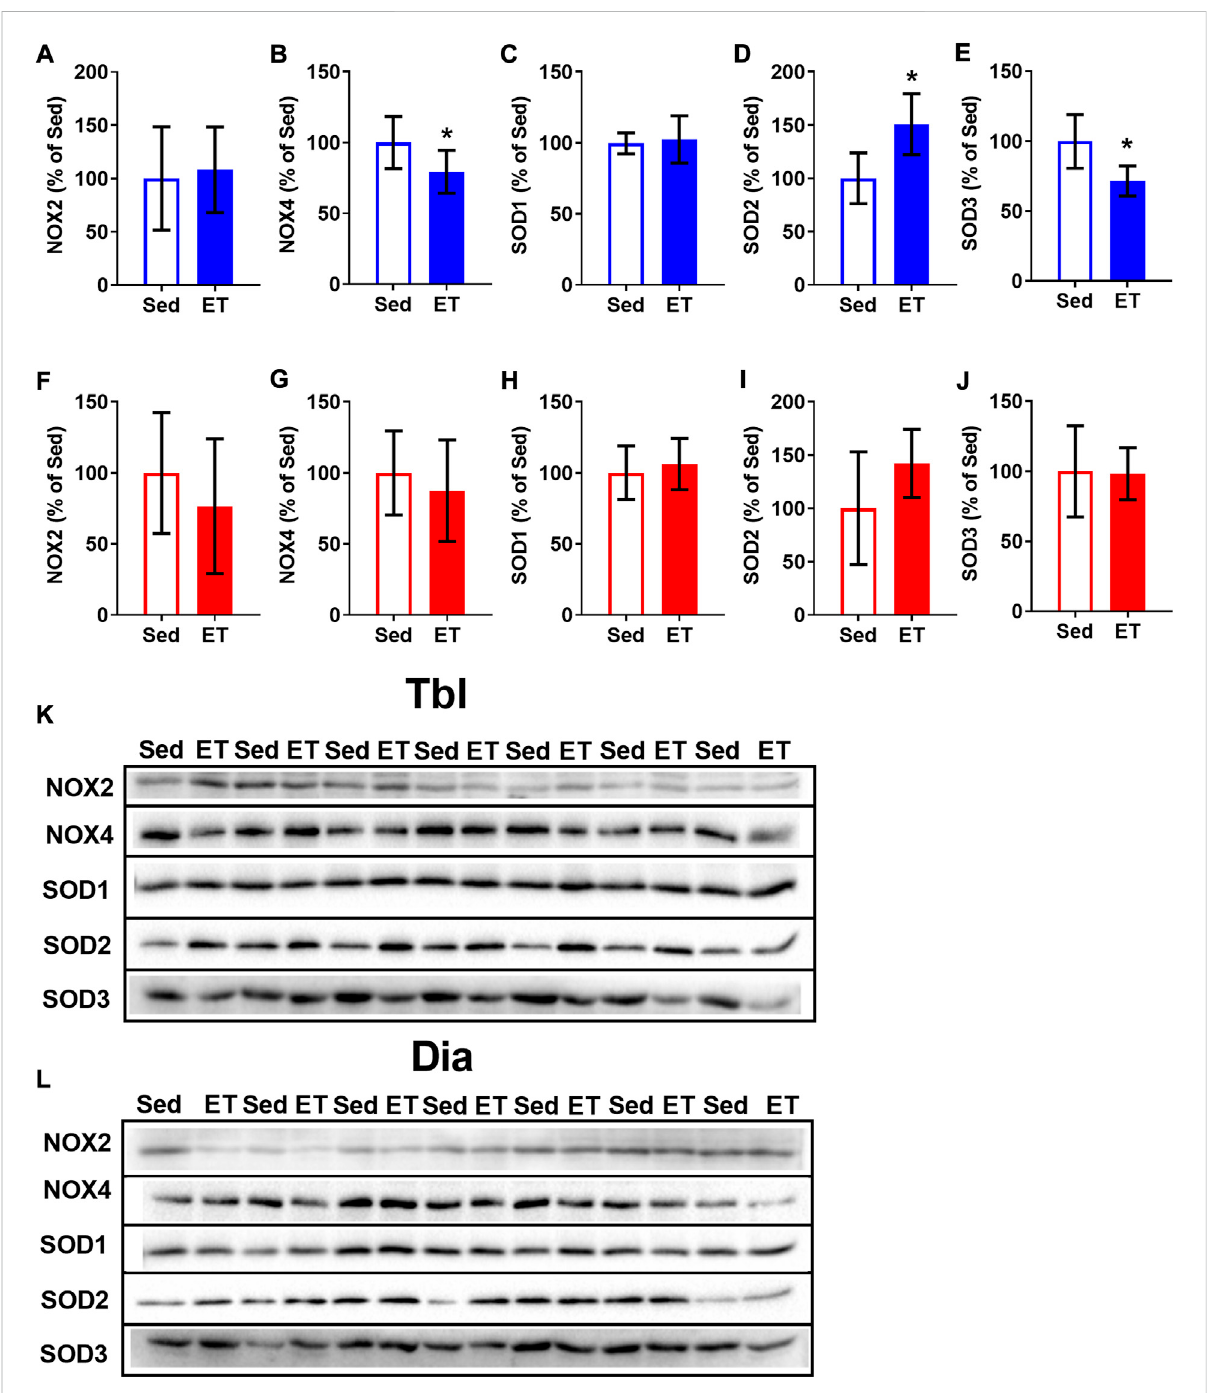
FIGURE 6 VoluntaryexercisetrainingchangedthecontentsofNOXandSODisoformsinlongheadofthetricepsbrachiimuscle(Tbl)butnotindiaphragm muscle (Dia). The relative contents of NOX2 (A,F) , NOX4 (B,G) , SOD1 (C,H) , SOD2 (D,I) and SOD3 (E,J) in Tbl (A – E) and Dia (F – J) of sedentary rats (Sed, n = 7) and voluntary exercise-trained (ET, n = 7) rats. Representative Western Blot images of NOX and SOD isoforms in Tbl (K) and Dia (L) of sedentary and voluntary exercise-trained rats. * p < 0.05 compared to sedentary group (unpaired Student ’ s